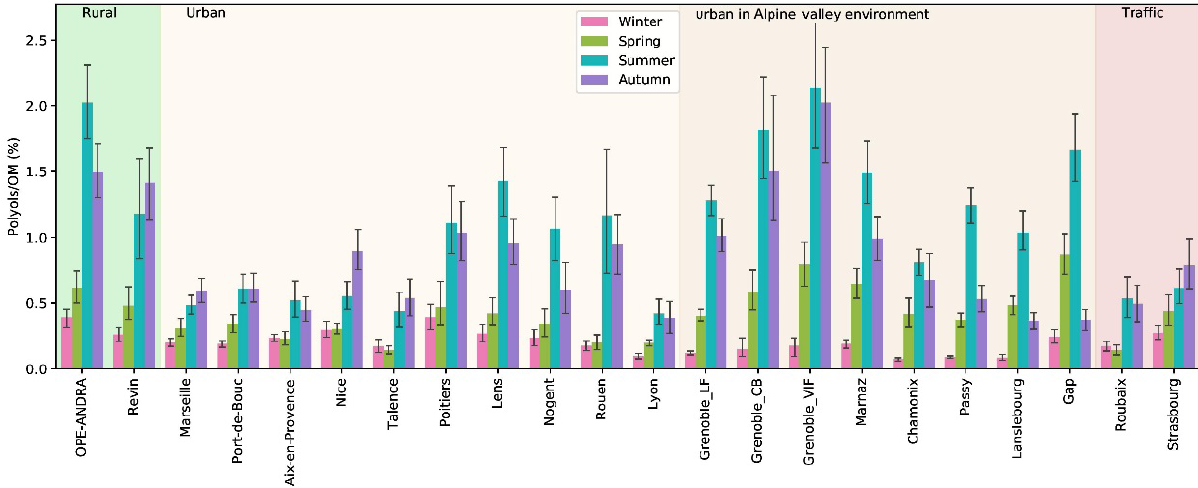
Figure 8. Spatial and seasonal distributions of mean contributions (in %) of polyols to the organic matter content of PM for various types of sites in France. Daily time series of organic carbon (OC) were not available for the following sites: Gardanne, Mallet, and Meyreuil. Error bars correspond to standard deviations calculated with seasonal